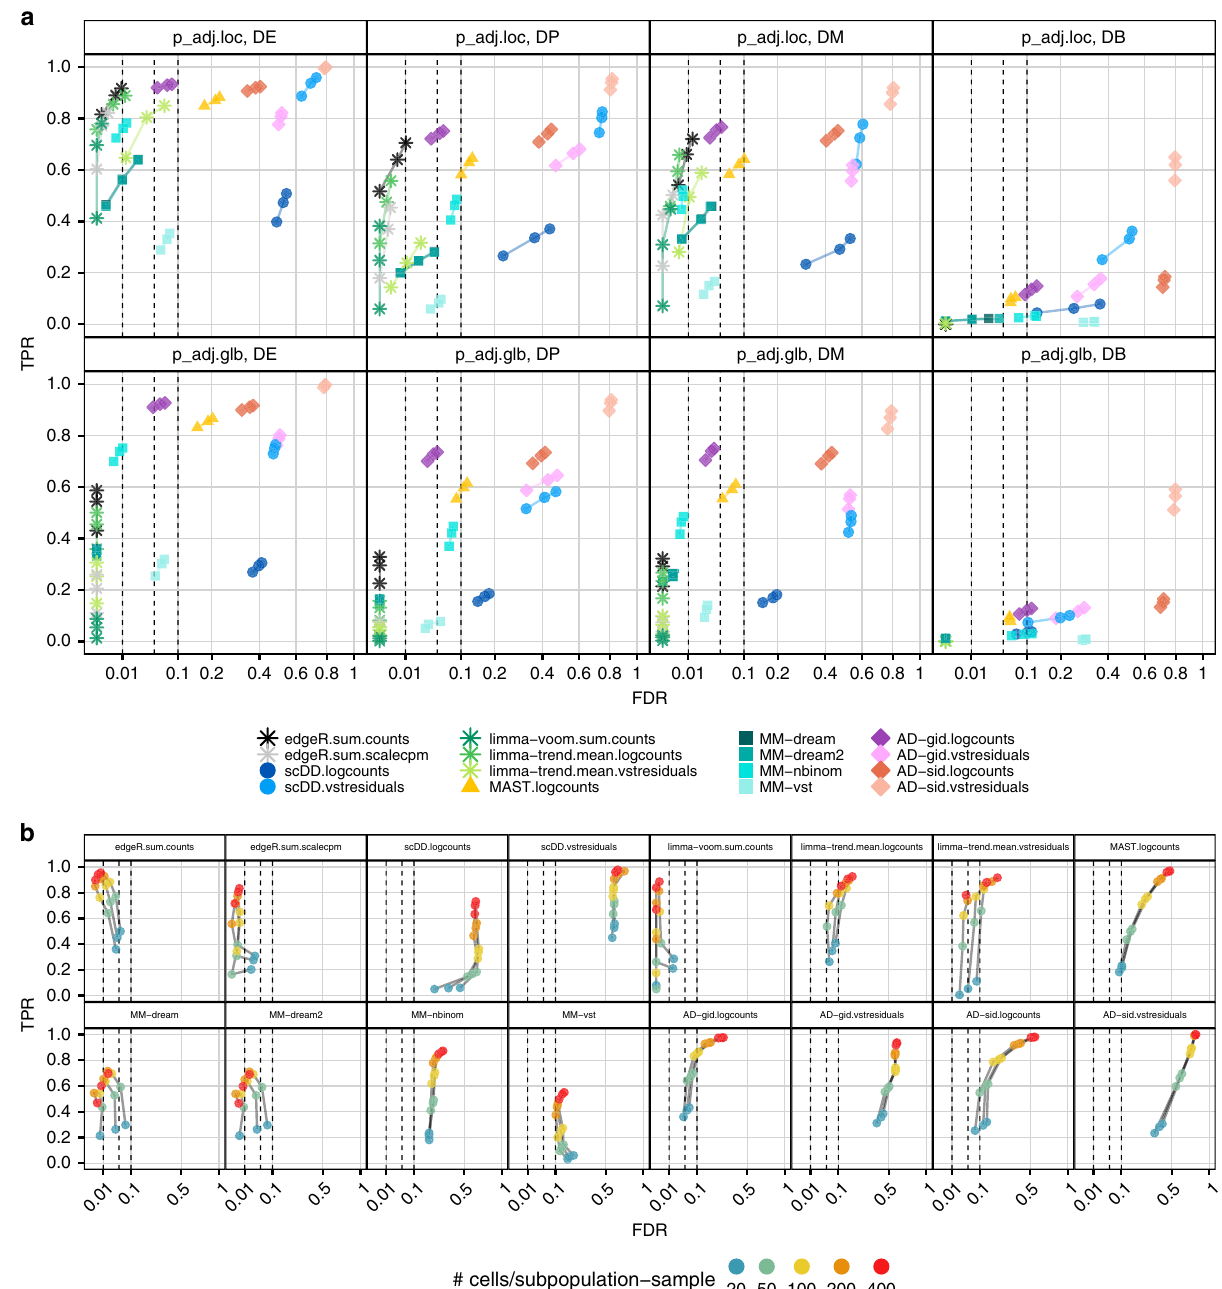
Fig. 2 DS method performance across p value adjustment types, differential distribution categories, and subpopulation-sample cell counts. All panels show observed overall true positive rate (TPR) and false discovery rate (FDR) values at FDR cutoffs of 1%, 5%, and 10%; dashed lines indicate desired FDRs (i.e., methods that control FDR at their desired level should be left of the corresponding dashed lines). For each panel, performances were averaged across fi ve simulation replicates, each containing 10% of DS genes (of the type speci fi ed in the panel labels of ( a ), and 10% of DE genes for ( b ); see Fig. 1b for further details). a Comparison of locally and globally adjusted p values, strati fi ed by DS type. Performances were calculated from subpopulation-level (locally) adjusted p values (top row) and cross-subpopulation (globally) adjusted p values (bottom row), respectively. b Performance of detecting DS changes according to the number of cells per subpopulation-sample, strati fi ed by the